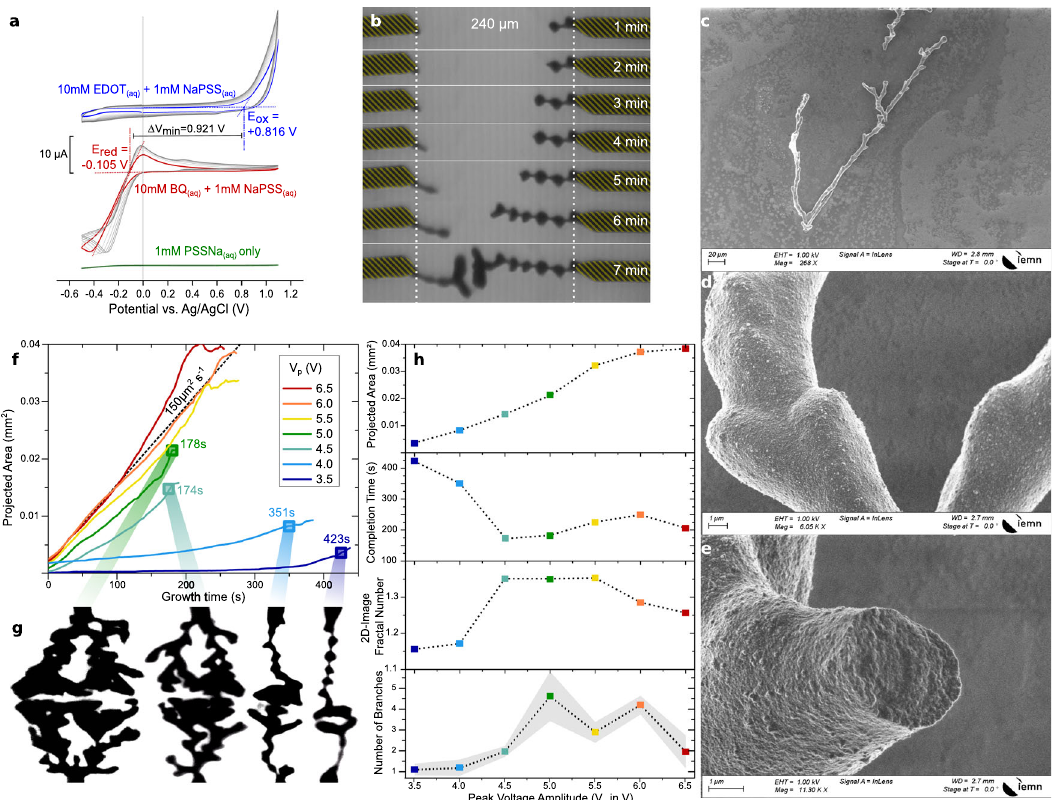
Fig. 2 ePEDOT dendrites and their morphological control by the voltage amplitude ( V p ). a Cyclic Voltammetry for the two Au-wire 1 mM NaPSS (aq) electrochemical system and its behavior without electrochemically active species (in green), with 10 mM EDOT (aq) (in blue), and with 10 mM BQ (aq) (in red). b Microscope pictures of one ePEDOT dendritic formation at different time lapses of electropolymerization ( V p = 3.5 V, V off = 0 V, f = 80 Hz, dc = 50%). The yellow stripped regions represent the position of the two gold wires (identi fi ed from their position at t = 0 s), in a fresh 10 mM EDOT (aq) + 10 mM BQ (aq) + 1 mM NaPSS (aq) electrolyte. c – e Scanning electron microscope images of an ePEDOT dendritic structure after extraction from its electrolyte. f Projected area over time for different dendrites grown at different V p ( V off = 0 V, f = 80 Hz, dc = 50%). g Contrasted microscope images of four different dendrites, grown at different V p ( V off = 0 V, f = 80 Hz, dc = 50%), taken at their completion times (highlighted with square marks in f ). h Relationship between V p and projected area, completion time, their image ’ s fractal number, and the averaged value of apparent number of branches for dendrites grown up to completion time ( V off = 0 V, f = 80 Hz, dc = 50%). The grey_colored error interval on the number of branches is set to the mean value ± SD (six values along L for each V p ). Scatters and curves ’ color encodings with peak voltage amplitude in f and h are Field activation of the process (as in each case, dendrites appear to grow along the longitudinal wire-to-wire axis) and lower EDOT oxidation rate at the gold/electrolyte interface than the ePEDOT/electrolyte one (implying low resistance of gold/ ePEDOT contacts and good conductivity of ePEDOT material).